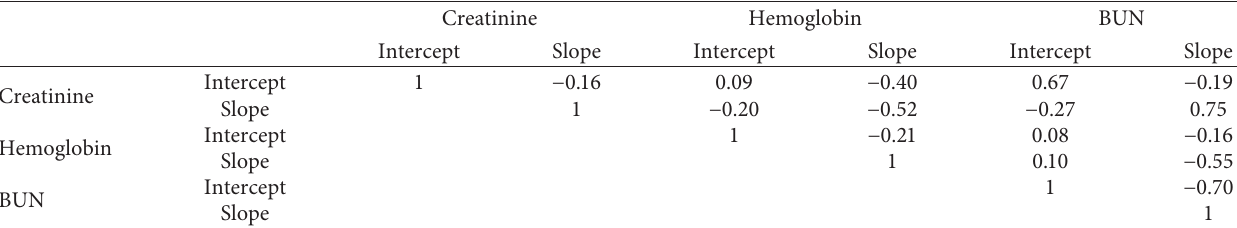
Table 2: The correlation matrix of random effects for the random intercepts and random slops of the multivariate joint